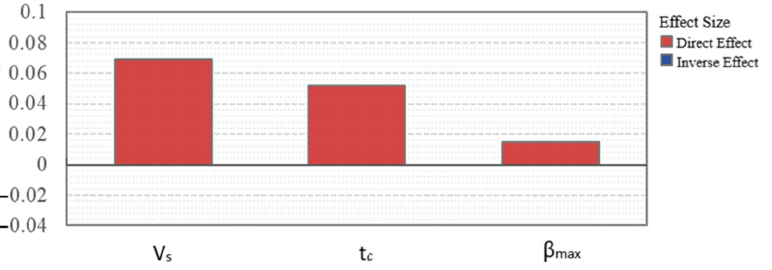
Figure 3. Relationship between the discharge time ( t d ) and the input variables ( V s , β max , t c ) . To present the relationship between the mechanical energy storage efficiency (cid:4666)𝜂 (cid:3041)(cid:3040) (cid:4667) and the input variables, a 4D bubble chart (Figure 4) was used. This is particularly useful because it allows the values obtained from optimization for the four variables to be shown. In particular, the x and y axes represent 𝛽 (cid:3040)(cid:3028)(cid:3051) and 𝜂 (cid:3041)(cid:3040) , respectively, while the diameter indicates the t c and the color indicates the V s .